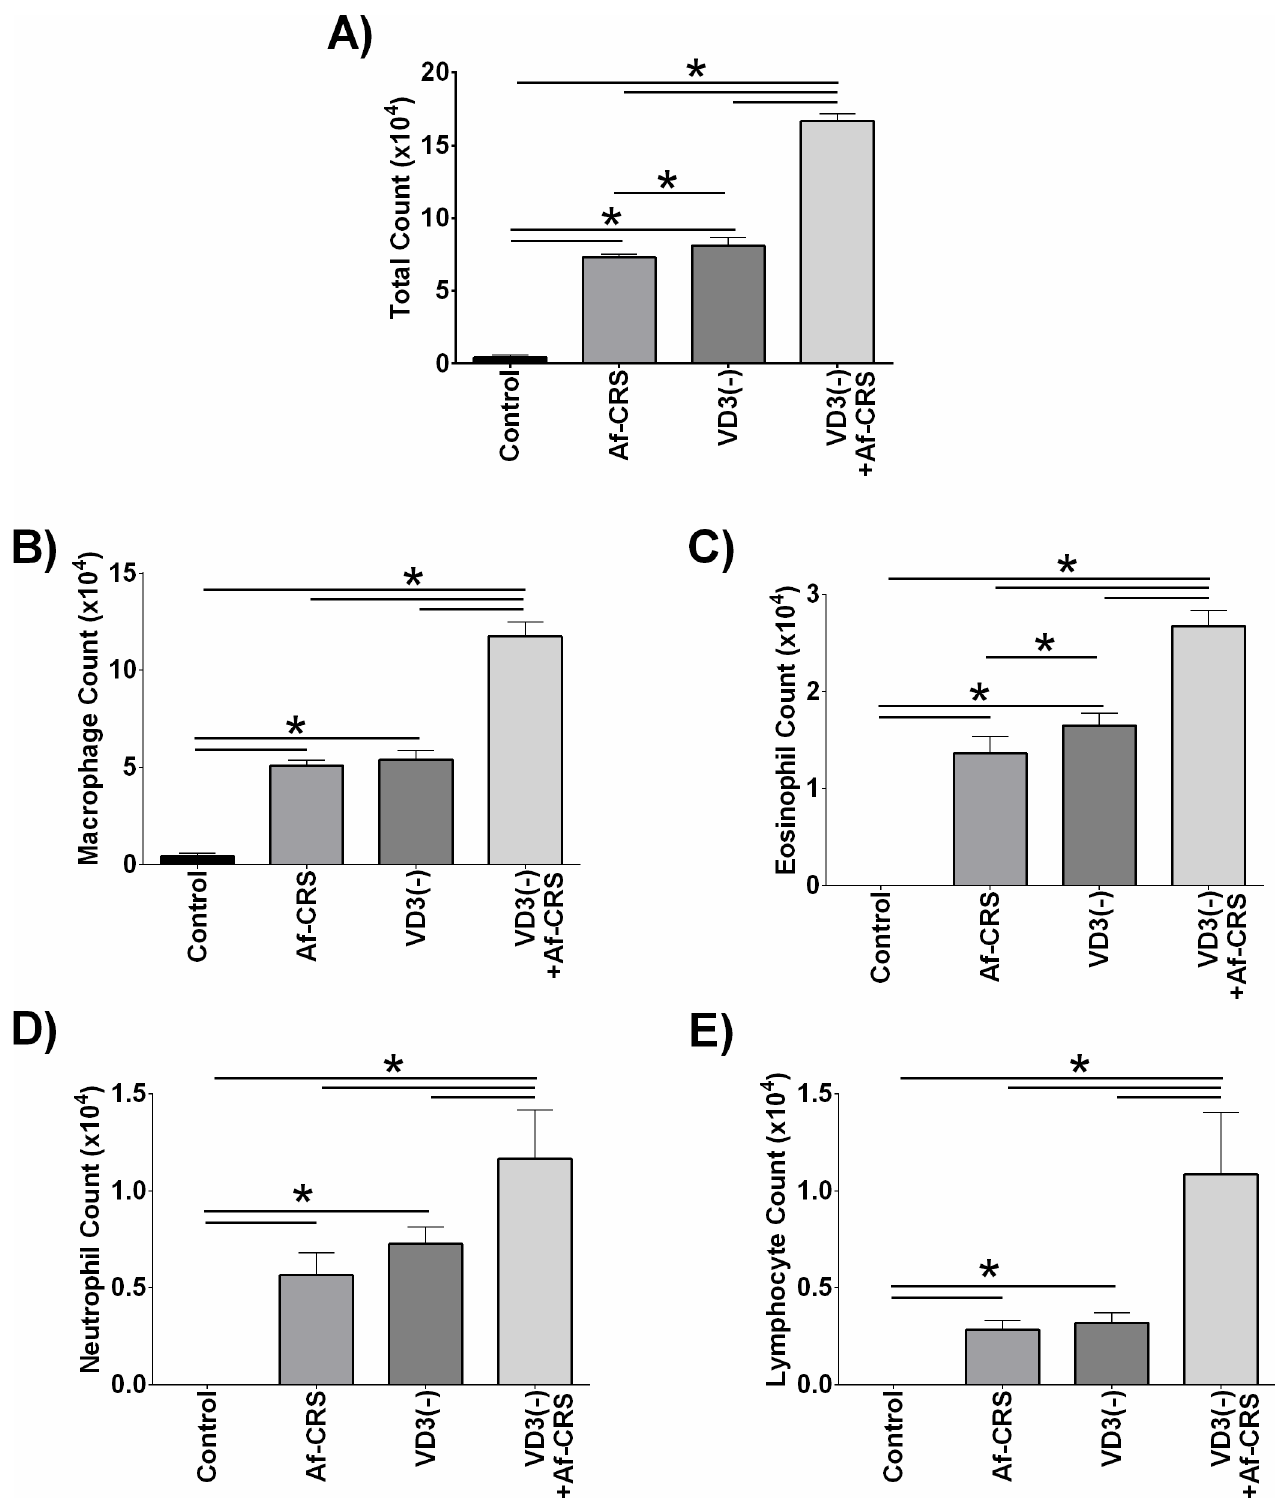
Fig 6. VD3 deficiency exacerbates changes in sinonasal immune cell infiltrate. Both Af-CRS and VD3 deficiencywere associatedwith increasedlavage cell counts of ( A ) total cells, ( B ) macrophages, ( C ) eosinophils, ( D ) neutrophils,and ( E ) lymphocytes. * p < 0.05betweenindicated groups. n = 4